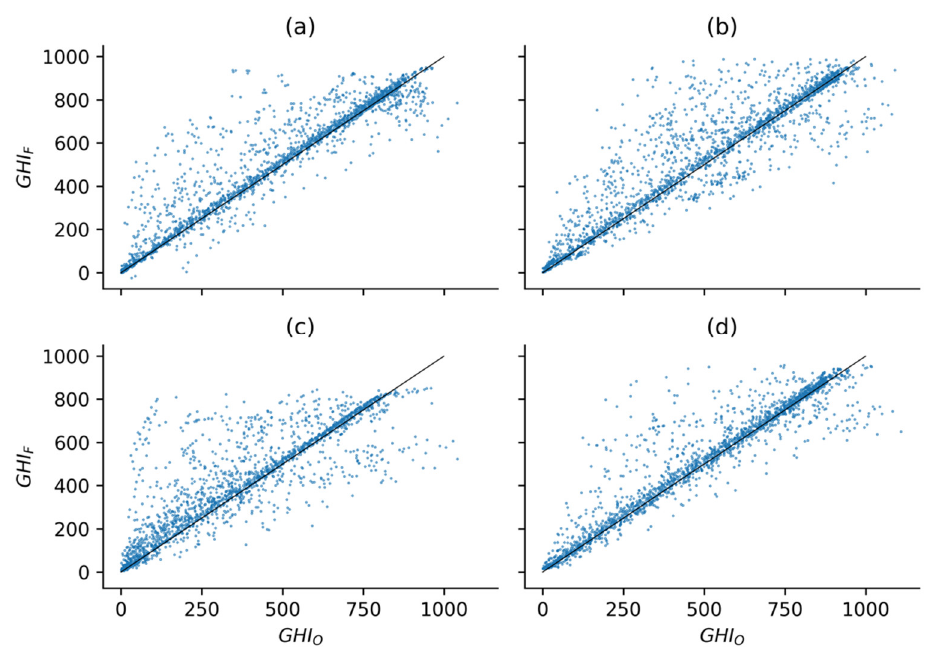
Figure 7. Forecasted GHI (ensemble mean) at 5 min compared to observed GHI in the benchmarking period for: ( a ) QLD-A; ( b ) QLD-B; ( c ) VIC-A; ( d ) QLD-C. The reference line y = x is shown in black.